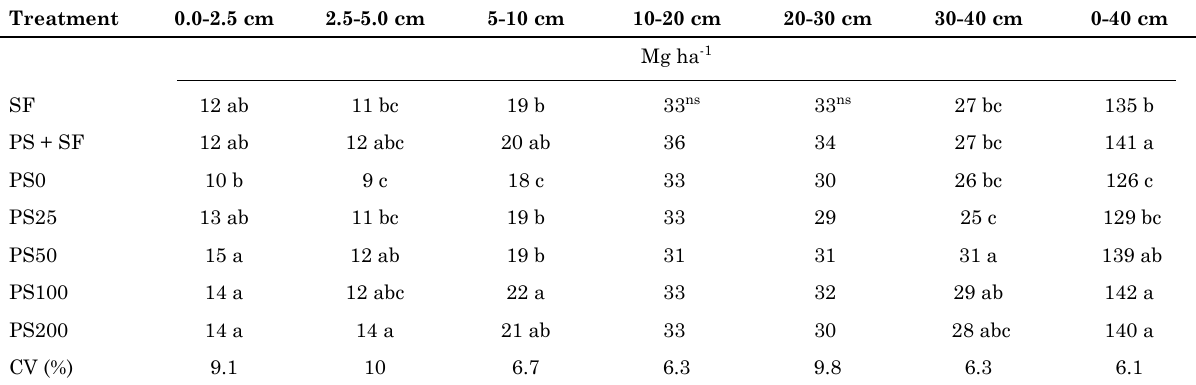
table 2. stock of total organic carbon (tOC) in the layers 0.0-2.5; 2.5-5.0; 5-10; 10-20; 20-30; 30-40 and 0-40 cm of a typic Hapludox, cultivated for nine years with no-tillage maize and oat, fertilized annually with soluble fertilizer (sF), pig slurry (Ps) rates up to 200 m 3 ha -1 and combined Ps +